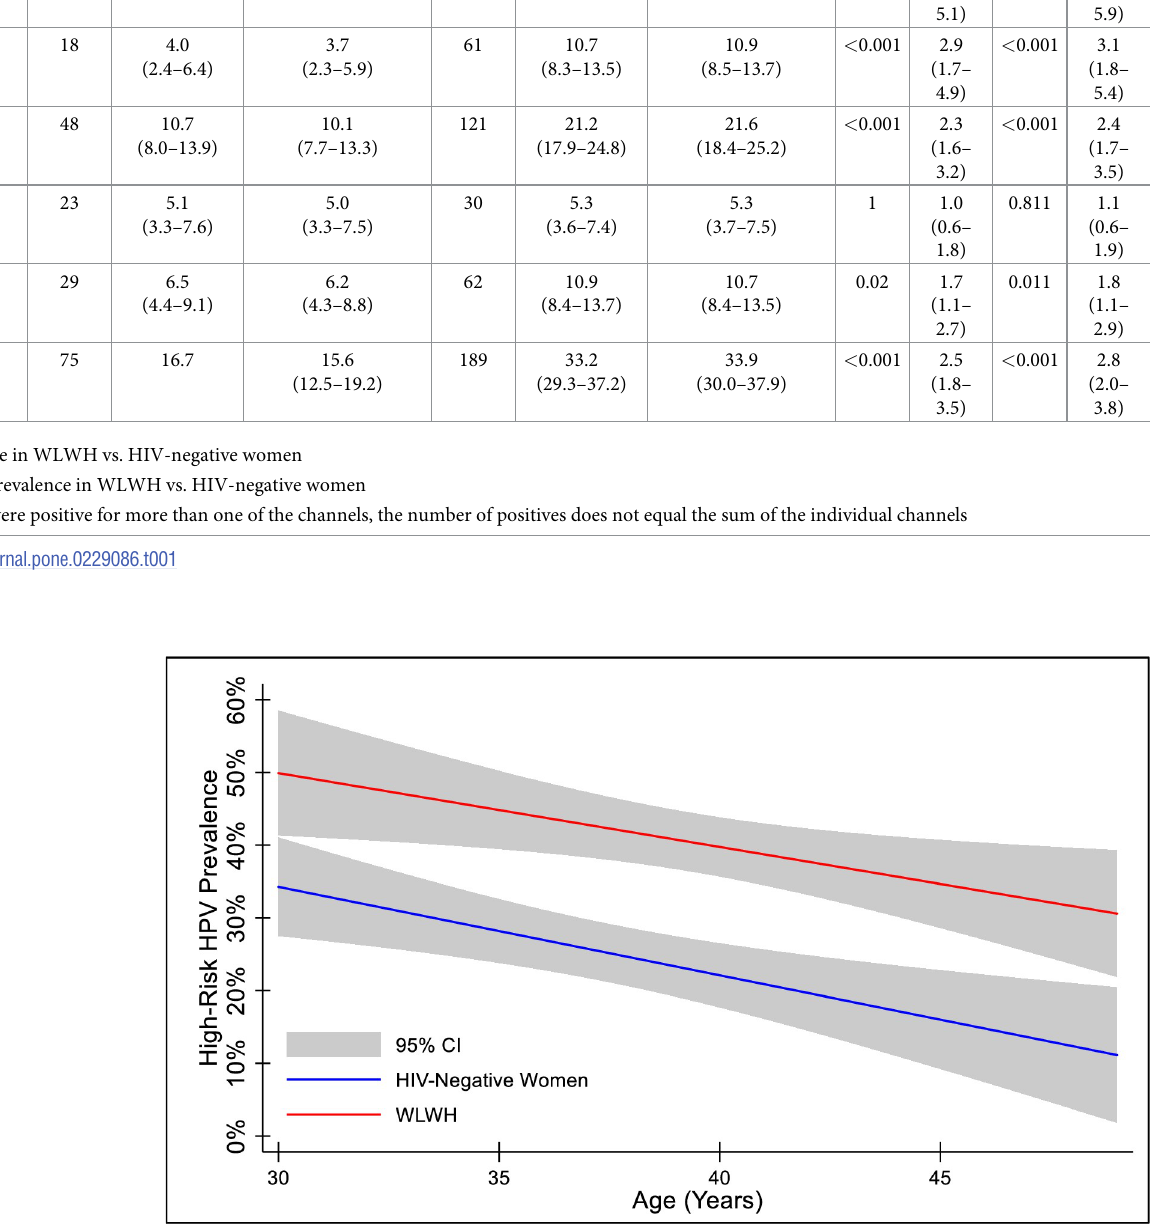
Fig 1. Prediction of high-risk human papillomavirus (HPV) prevalence, stratified by HIV status, by age. Abbreviation: HIV, human immunodeficiency virus; WLWH, women living with HIV.